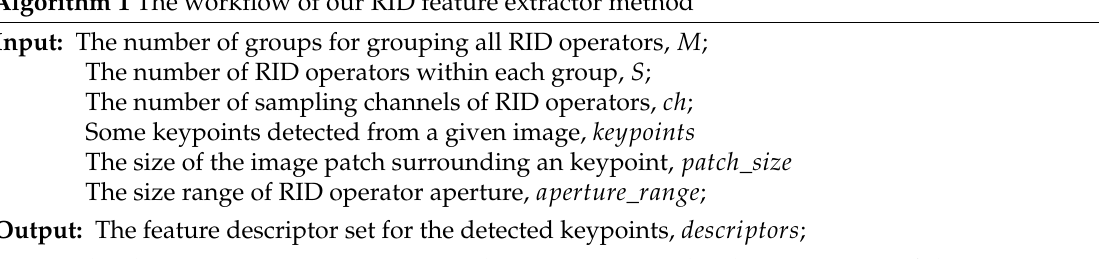
Algorithm 1 The workflow of our RID feature extractor